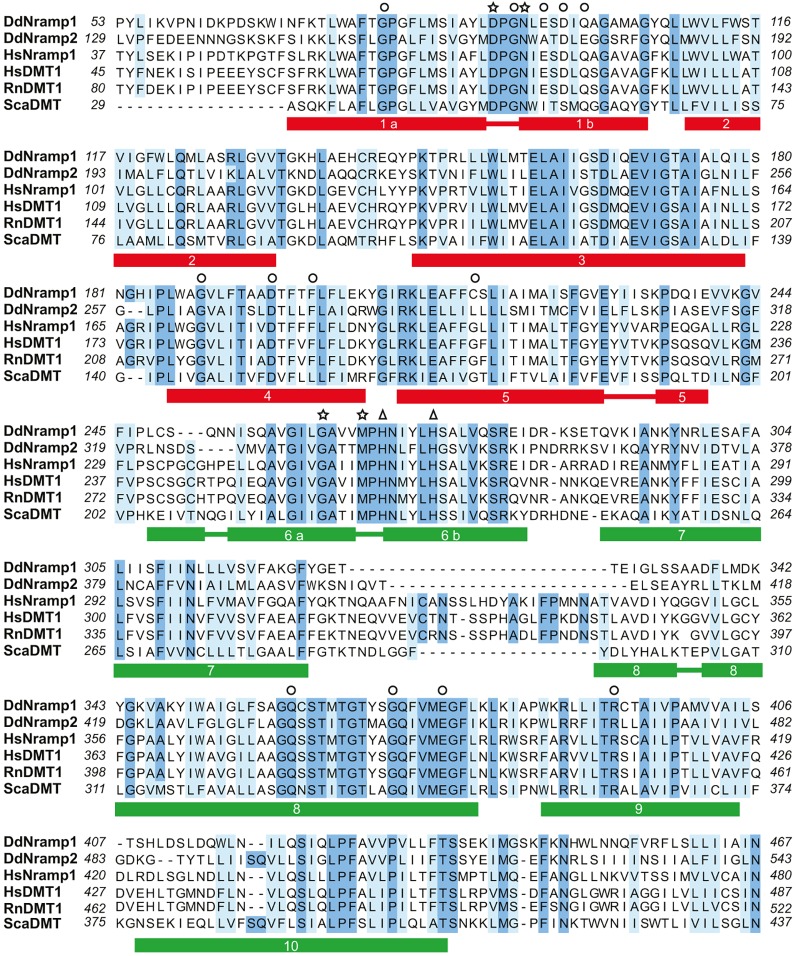
Sequence alignment. Sequences of Dictyostelium Nramp1 and Nramp2, human Nramp1 and DMT1 (formerly Nramp2) (isoform1), rat DMT1 and Staphylococcus capitis DMT were aligned with ClustalW. Identical or homologous residues are shown in sky blue or light blue, respectively, and non-conserved residues are in white. Only the first ten transmembrane domains are shown, with the numberings reporting the amino acid residues of each protein. The predicted transmembrane domains are as described previously (Czachorowski et al., 2009; Ehrnstorfer et al., 2014). The stars point to the four amino acid residues coordinating iron binding, and the triangles to the two histidine residues required for proton dependency of transport (Czachorowski et al., 2009; Ehrnstorfer et al., 2014). Amino acids whose spontaneous or induced mutations in human or rodent DMT1 result in reduction of uptake and/or changes in specificity or pH dependency are indicated by circles (see: Fleming et al., 1997; Lam-Yuk-Tseung et al., 2003; Cohen et al., 2003; Courville et al., 2006; Beaumont et al., 2006; Czachorowski et al., 2009; Iolascon et al., 2006).